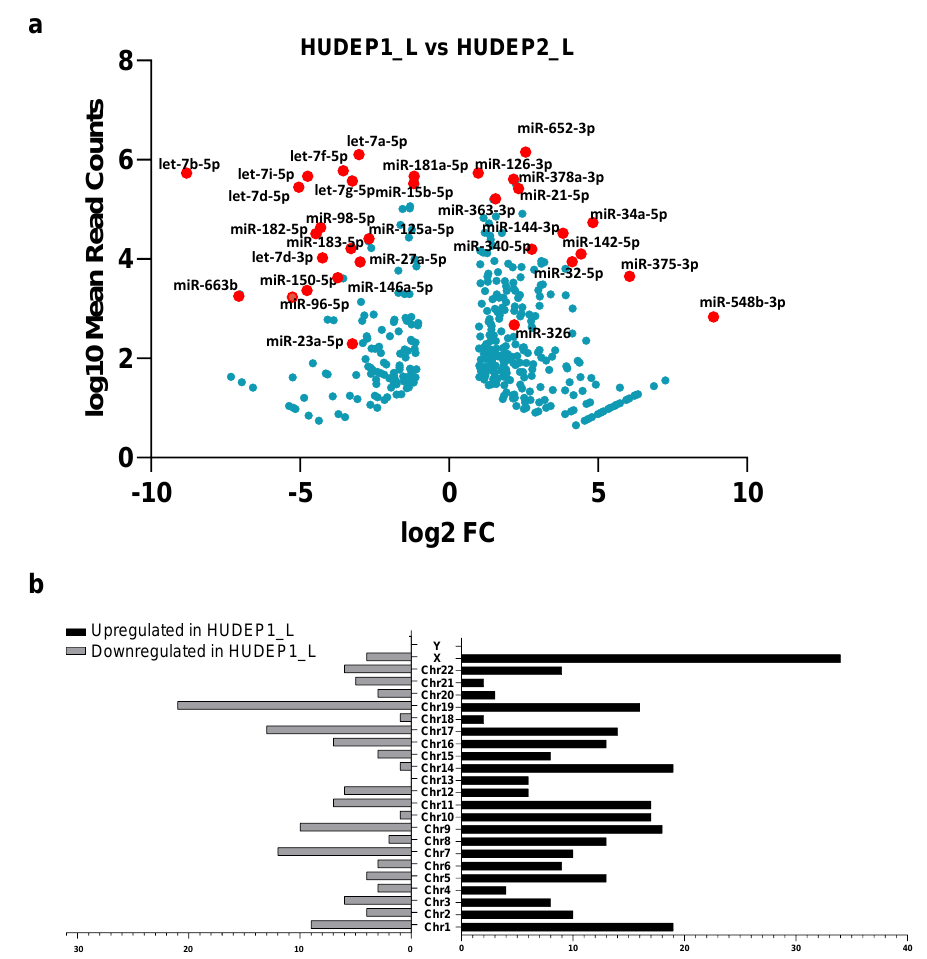
Figure 6. Differential expression analysis in HUDEP1_L vs. HUDEP2_L for known miRNAs. DEGseq provides pointers to miRNAs and related pathways mechanistically linked to globin switching. ( a ) Differentially expressed (DE) miRNAs in HUDEP1_L vs. HUDEP2_L. Fold changes were plotted as the log 2 FC of miRNA expression in samples against the log 10 mean normalized miRNA counts calculated by differential expression analysis. To aid legibility, only a selection of miRNAs of interest and DE miRNAs with high fold change or high levels of expression are labeled (see Table S11 for a full list). ( b ) The number of HUDEP1_L vs. HUDEP2_L DE known miRNAs located in different